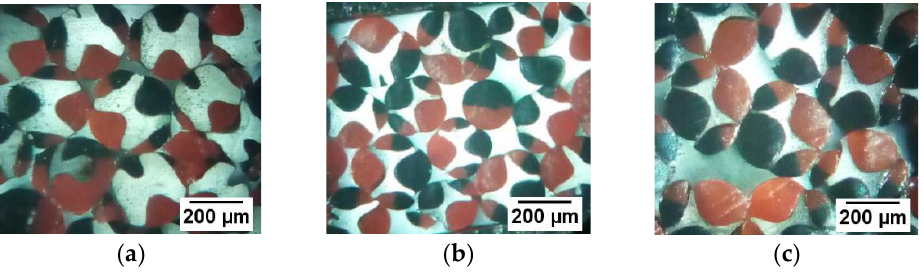
Figure 11. Cross-sections of “H-shaped” fibers with different flow ratios. ( a ) The flow ratio is 1:2:1; ( b ) the flow ratio is 1:1:1; ( c ) the flow ratio is 2:1:2.